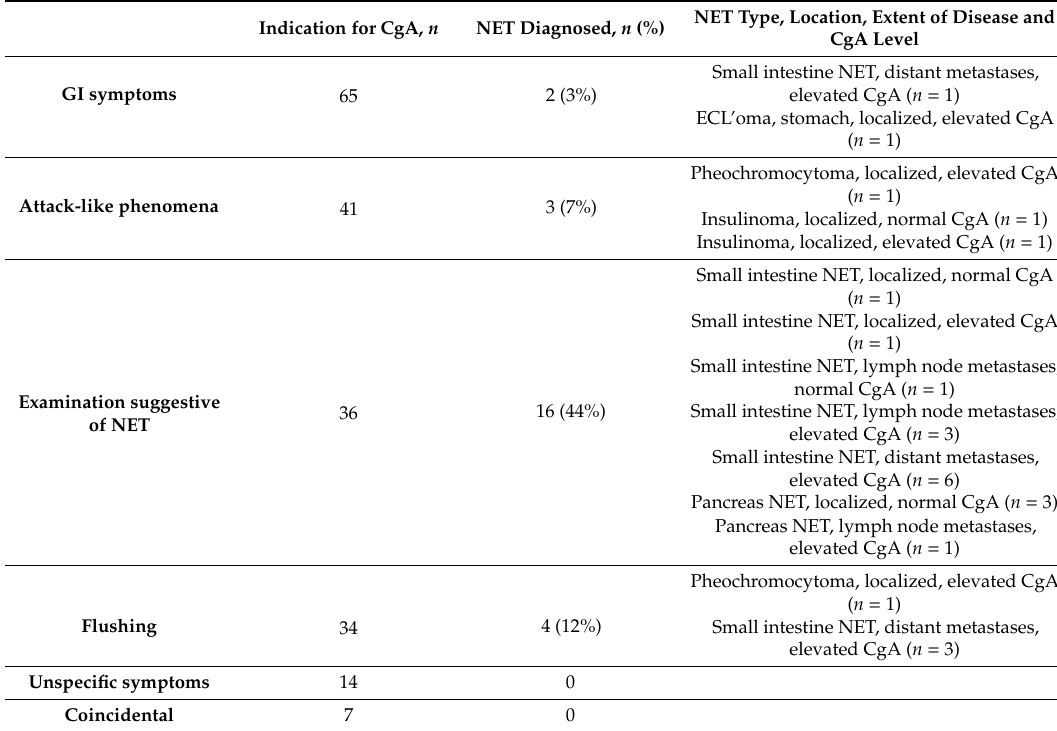
Table 5. Indications for CgA measurements, frequency of NET diagnosis and NET type. Indication for CgA, n NET Diagnosed, n (%)